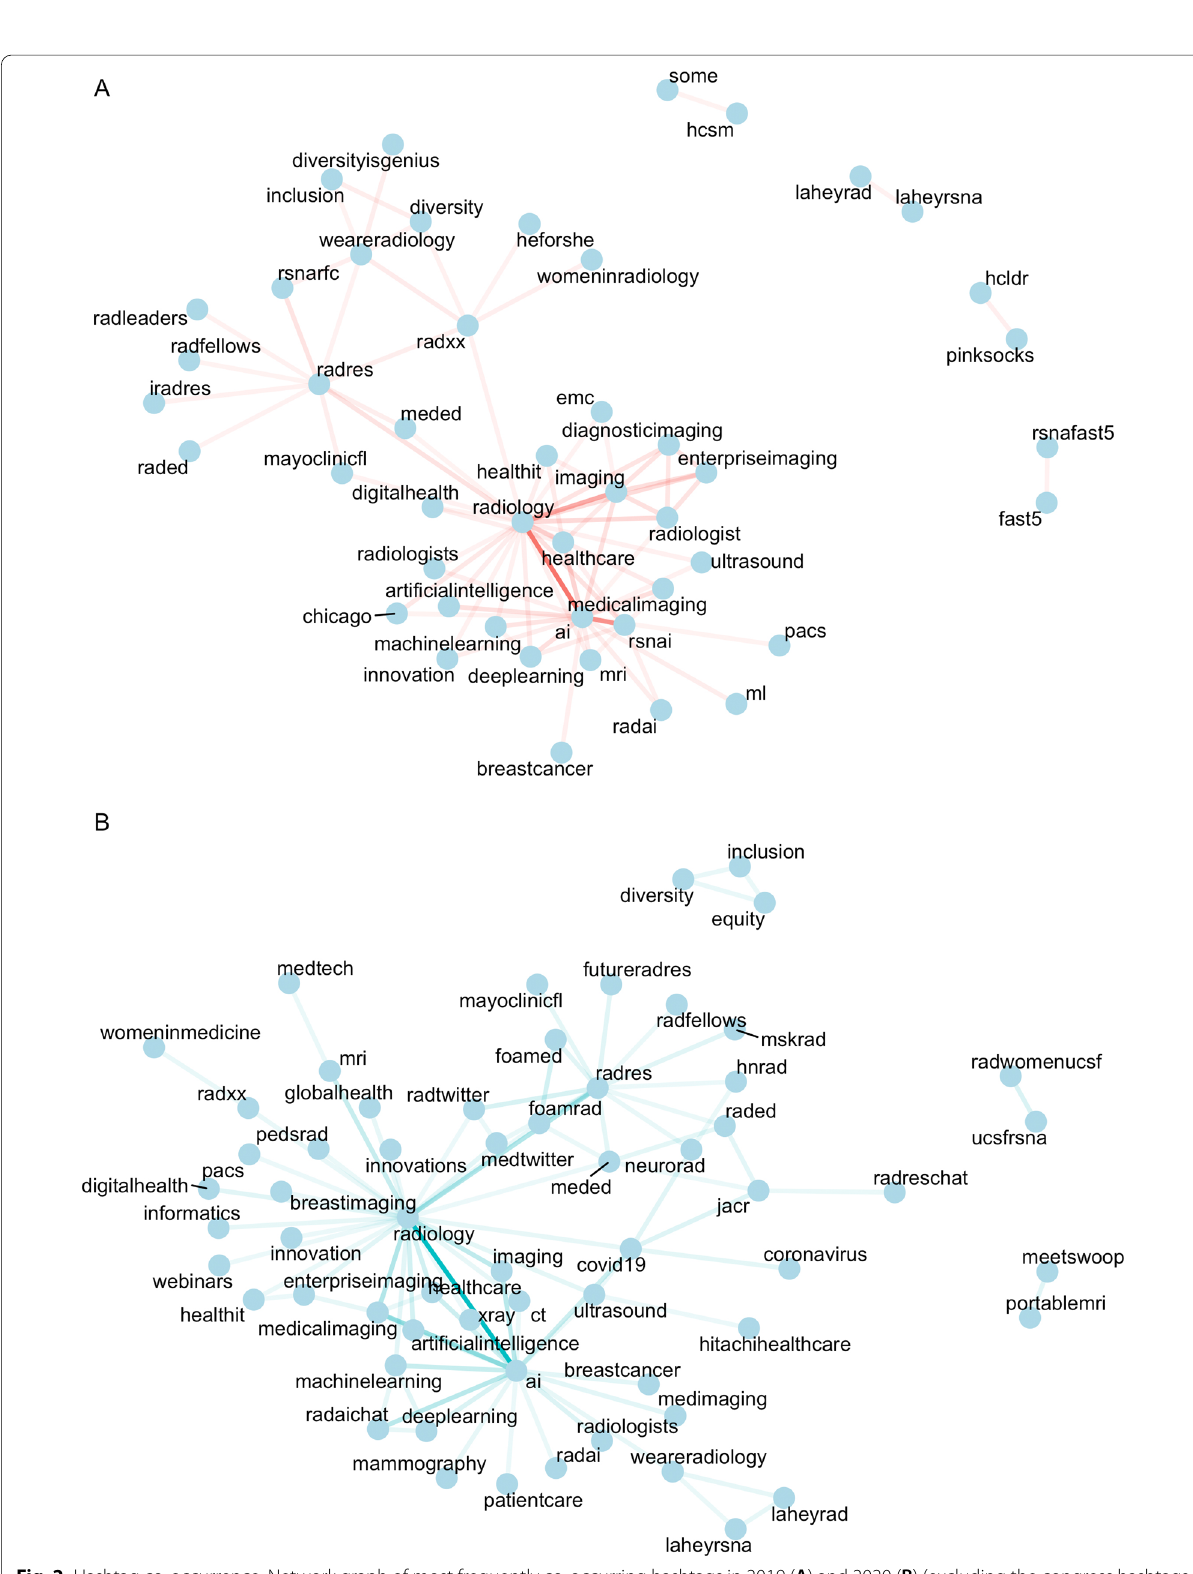
Fig. 2 Hashtag co-occurrence. Network graph of most frequently co-occurring hashtags in 2019 ( A ) and 2020 ( B ) (excluding the congress hashtags #rsna19, #rsna2019, #rsna20, #rsna2020). Strength of connection indicates frequency of